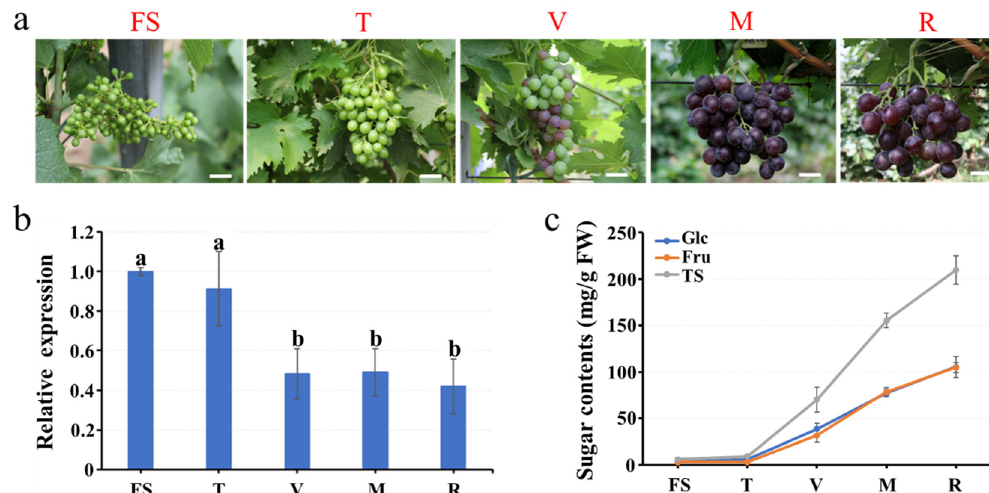
Figure 5. The relative expression level of the VvGH9 gene and the sugar content of ‘Muscat Hamburg’ grape fruit at five different developmental stages. ( a ) Fruit growth status in different developmental stages. Scale bars, 2 cm. ( b ) Relative VvGH expression in different berry developmental stages. ( c ) Sugar content determination results of grape berries. FS: fruit set; T: touching; V: véraison; M: mid-ripening; R: ripe. FW: fresh weight. The letters above the bars indicated the significant differences by student’s t -test ( p < 0.05). Three biological replicates were analyzed, and the error bars represented the SD.